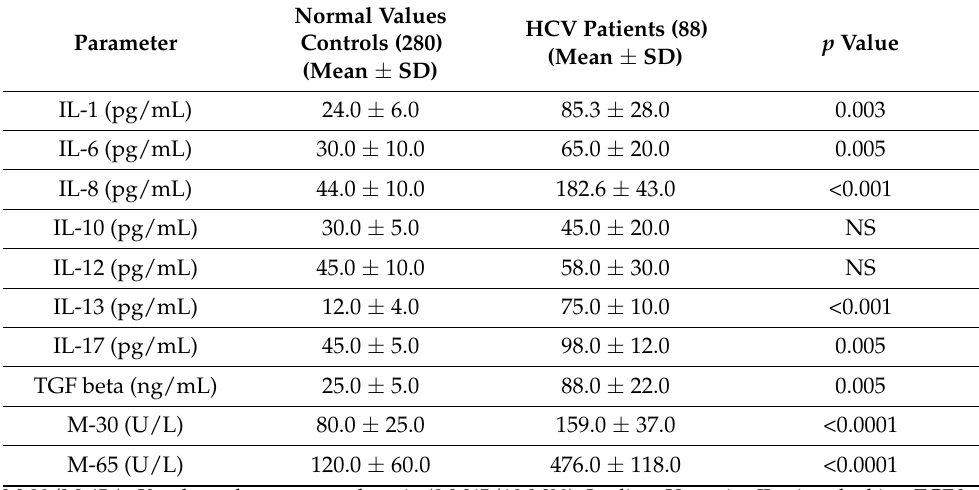
Table 2. Cytokines, chemokines, necrosis and apotosis in sera. Parameter